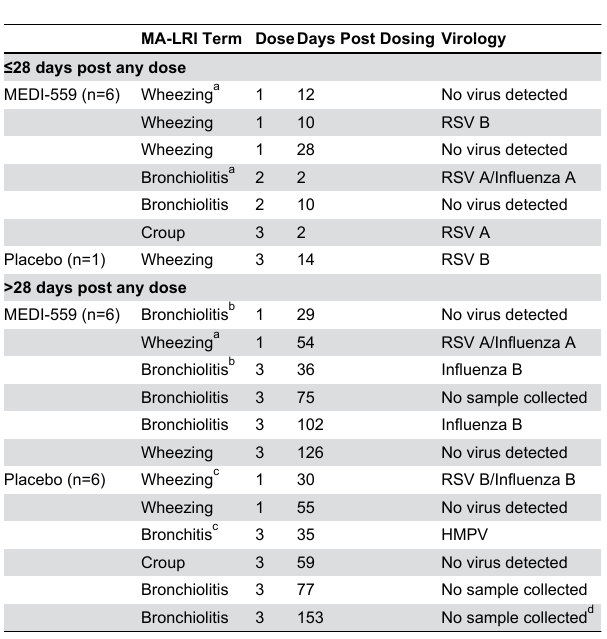
Table 3. Medically attended lower respiratory illness among MEDI-559 and placebo